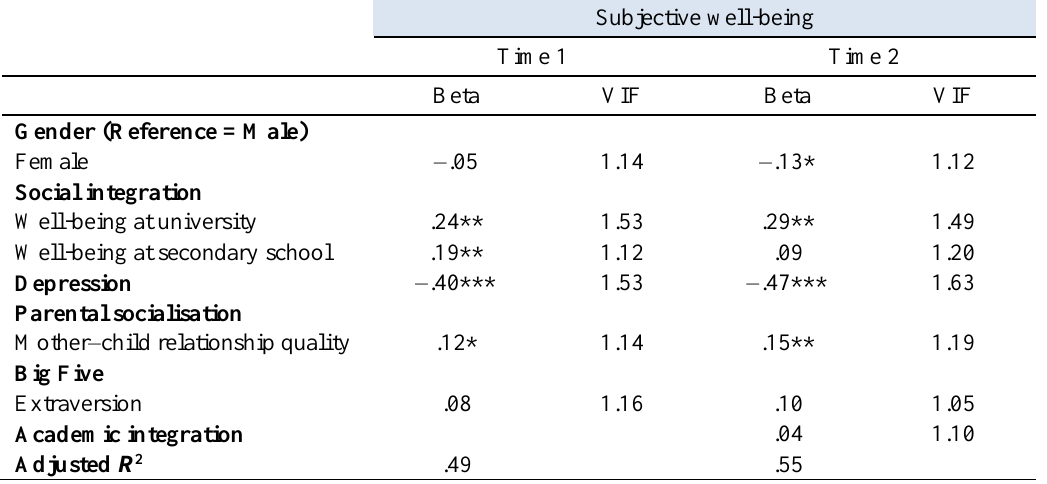
Multiple linear regression models with subjective well-being at Time 1 and Time 2 as outcome variables and standardised betas and variance inflation factor (VIF) values of independent